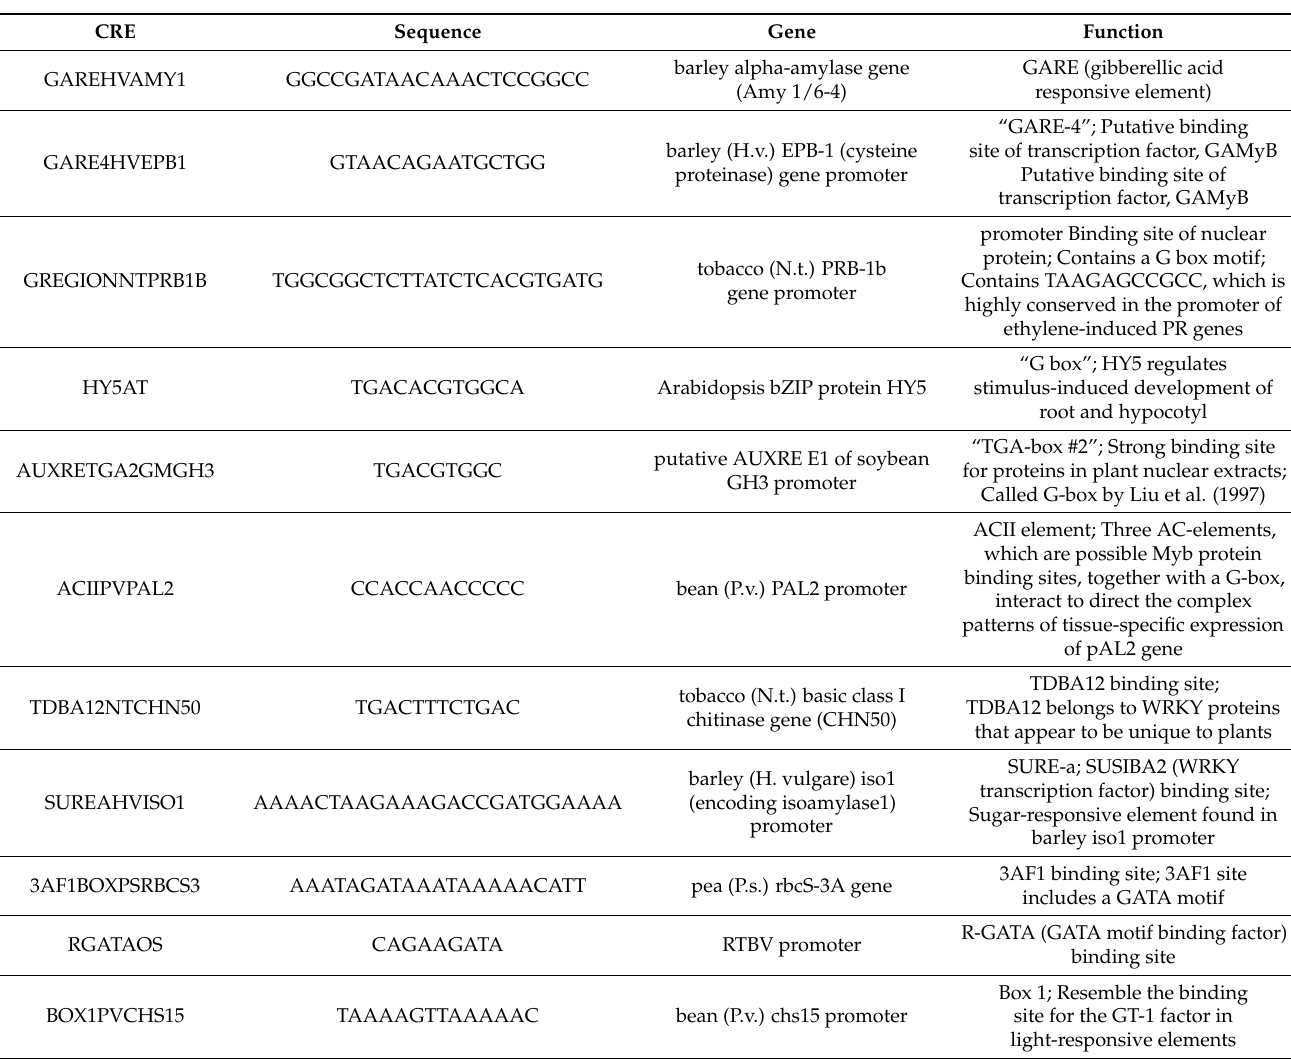
Table 3. List of Cis -regulatory elements (CREs) related to abiotic